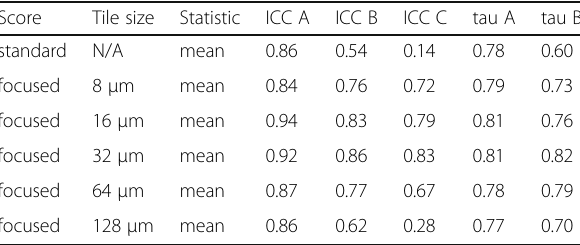
Table 1 Results of the tile size evaluation on data set A, B, and C. Kendall ’ s tau values were only computed for data set A and B because validity assumptions could only be made for these data sets. The tile size of the standard score was labeled as not applicable (N/A) because this score is practically unaffected by the tile